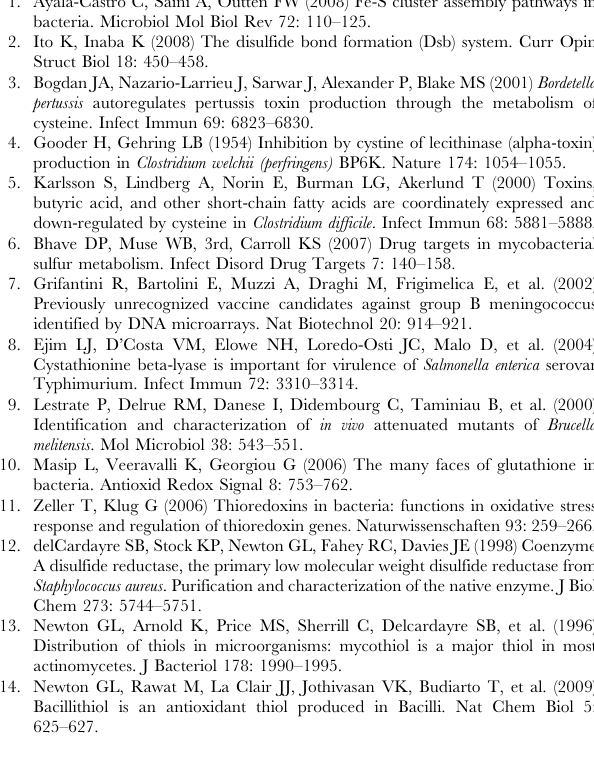
Figure S1 Cystine effect on stress resistance phenotypes of an S. aureus D cymR mutant. Disk diffusion assays were performed with 200 mM tellurite K 2 TeO 3 (A) or 200 mM CuSO 4 (B) in TSB medium with (white) and without (grey) 2 mM cystine. Strains